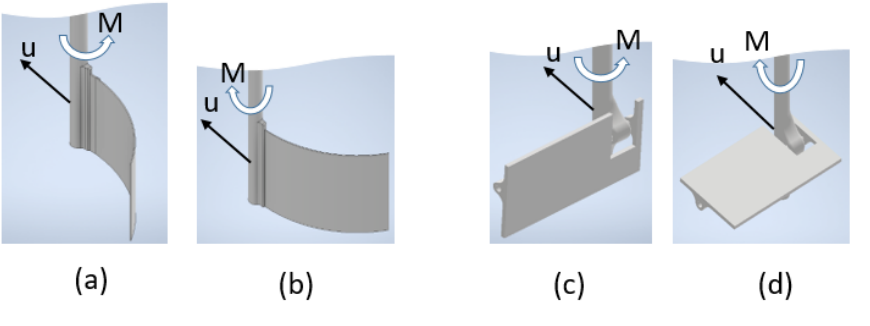
Figure 4. Two types of propulsion systems used for tests: the flexible fin during counterclockwise ( a ) and clockwise ( b ) movement; the flipper with an additional joint during the power ( c ) and return ( d )